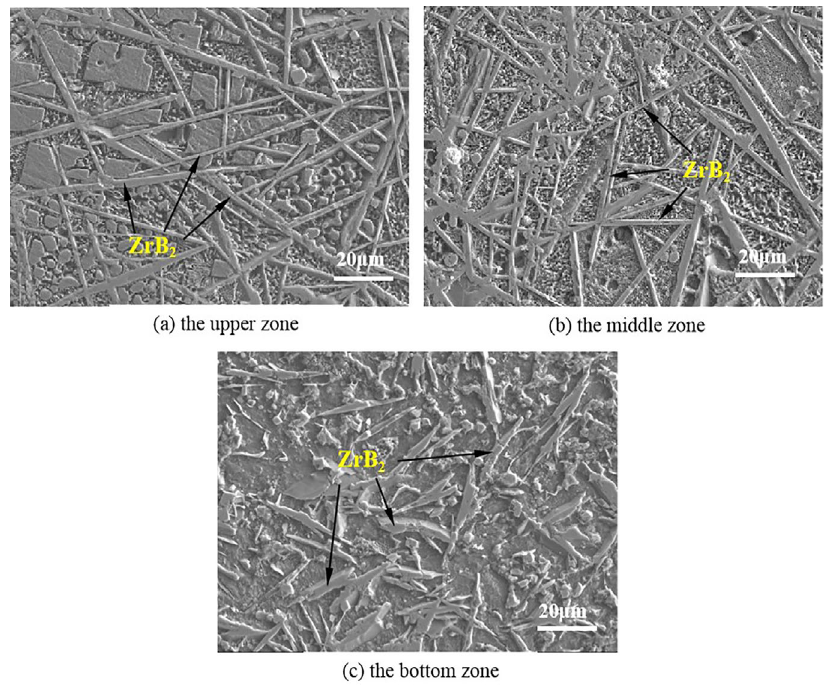
Figure 6. EPMA micrographs of sample S2 with a vertical distribution of reinforcements: (a)the upper zone; (b)the middle zone; (c)the bottom zone.